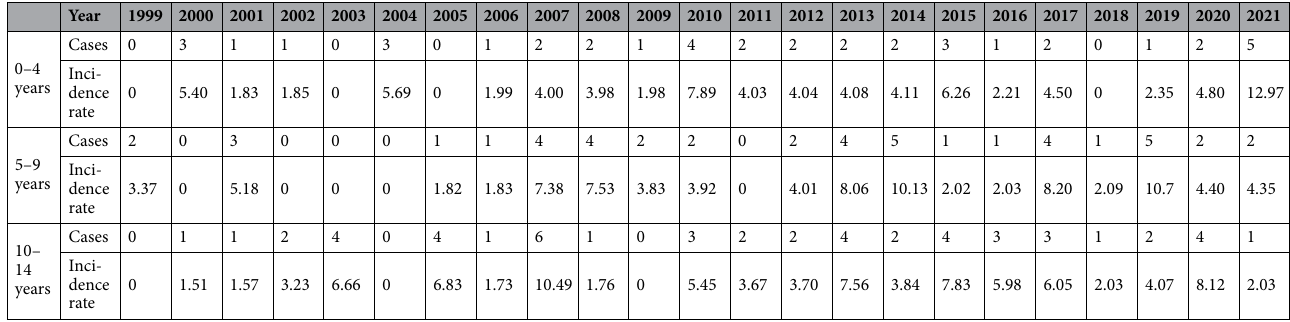
Table 1. Numbers of type 1 diabetes cases and incidences (/1000,000 year) among children of each age group during